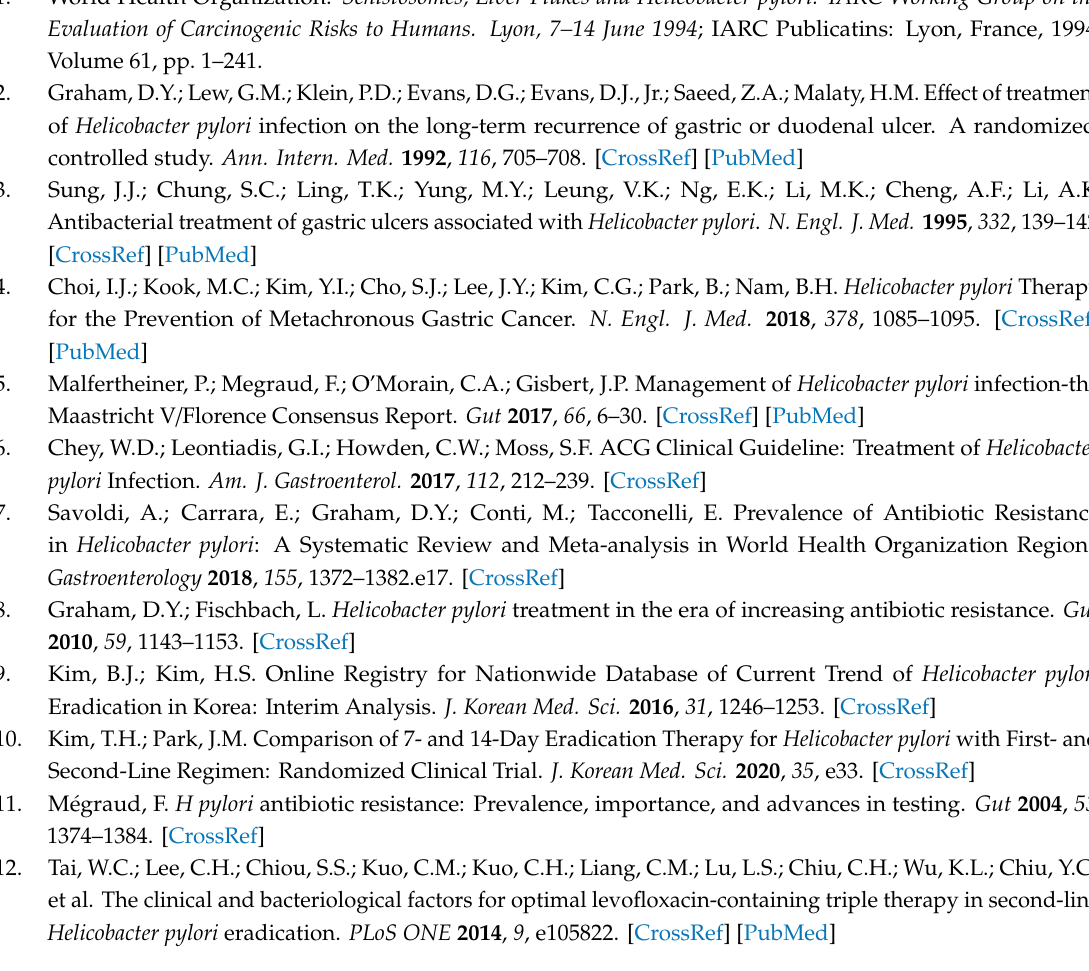
Table S1: Di ff erences in the resistance of Helicobacter pylori strains from the antrum and the body for each antibiotic agent ( n = 52), Table S2: MIC levels and resistance profiles of Helicobacter pylori strains of the included patients ( n =